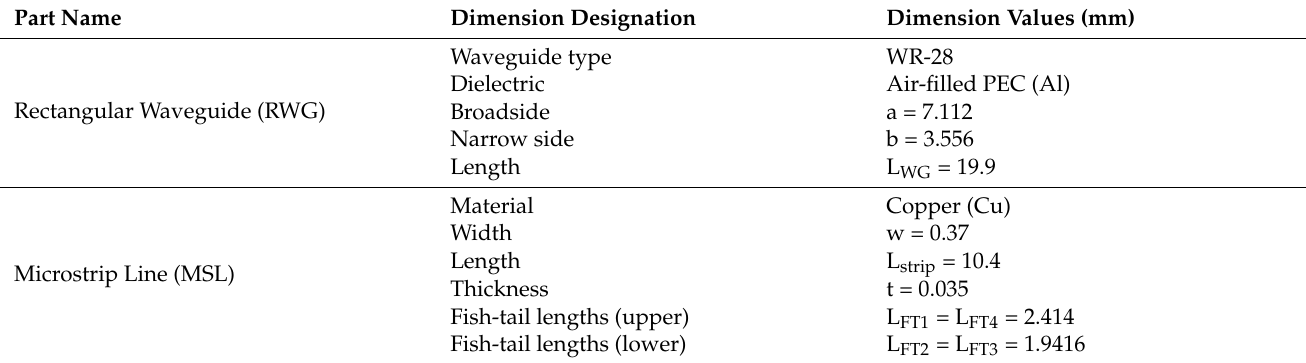
Table 1. Dimensions of the Ka-band MS Line-to-RWG